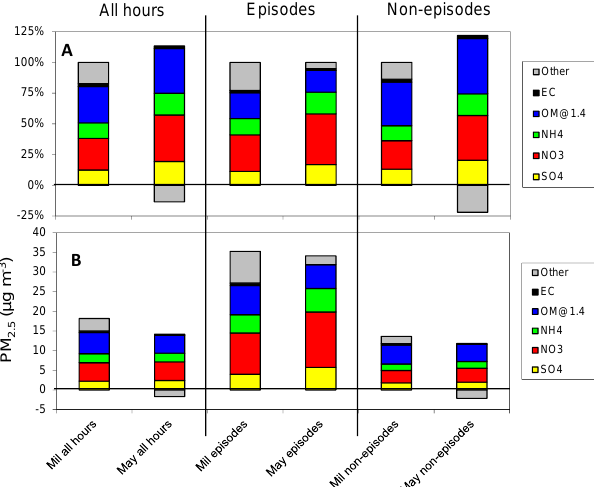
979 Figure 7. Inorganic and carbonaceous composition on a fractional (A) and absolute (B) basis. 980 Fig. 7. Inorganic and carbonaceous composition on a fractional (A) Negative concentrations (seen at Mayville) are from cases where the sum of species is greater 981 and absolute (B) basis. Negative concentrations (seen at Mayville) than the measured PM 2.5 mass measurement. 982 are from cases where the sum of species is greater than the measured PM 2 . 5 mass